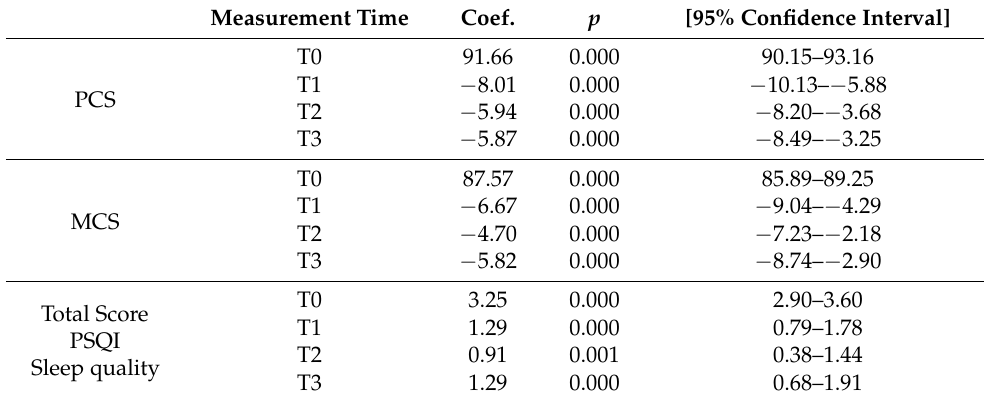
Table 5. Multivariate regression post MANOVA.